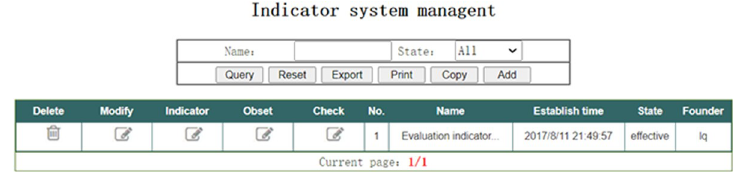
Fig 8. Indicator system